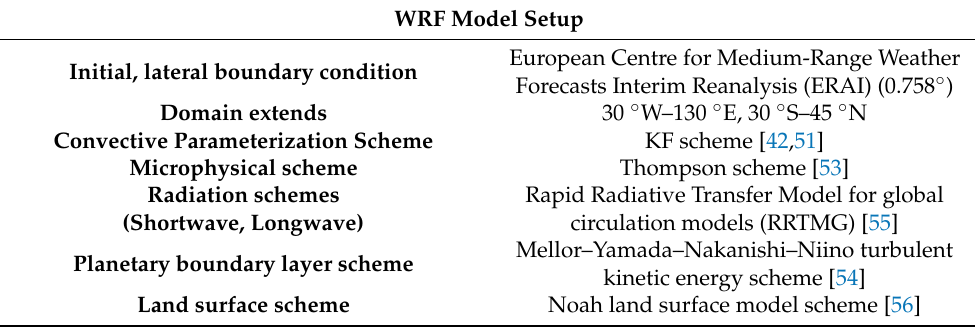
Table 1. Details for WRF model configurations and physical parameterization schemes used in this